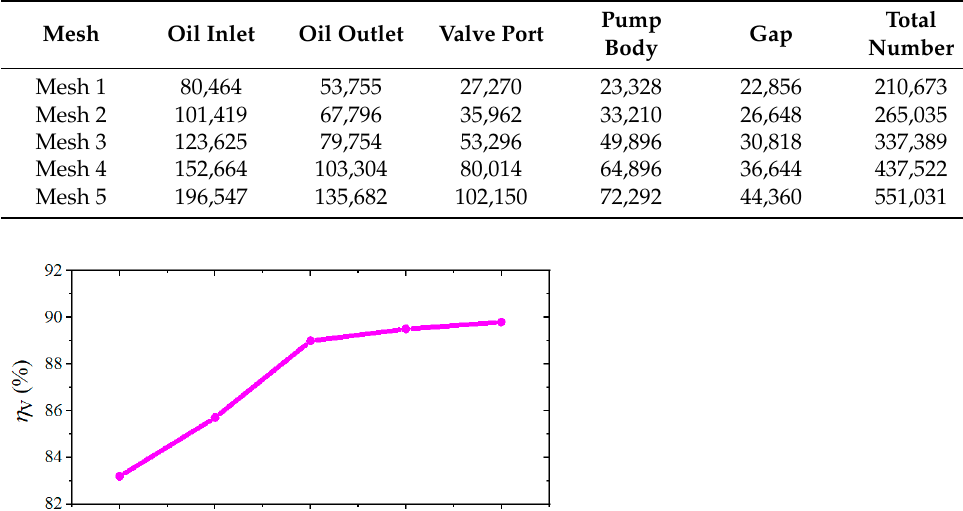
Figure 8. Mesh 3 ES distribution.